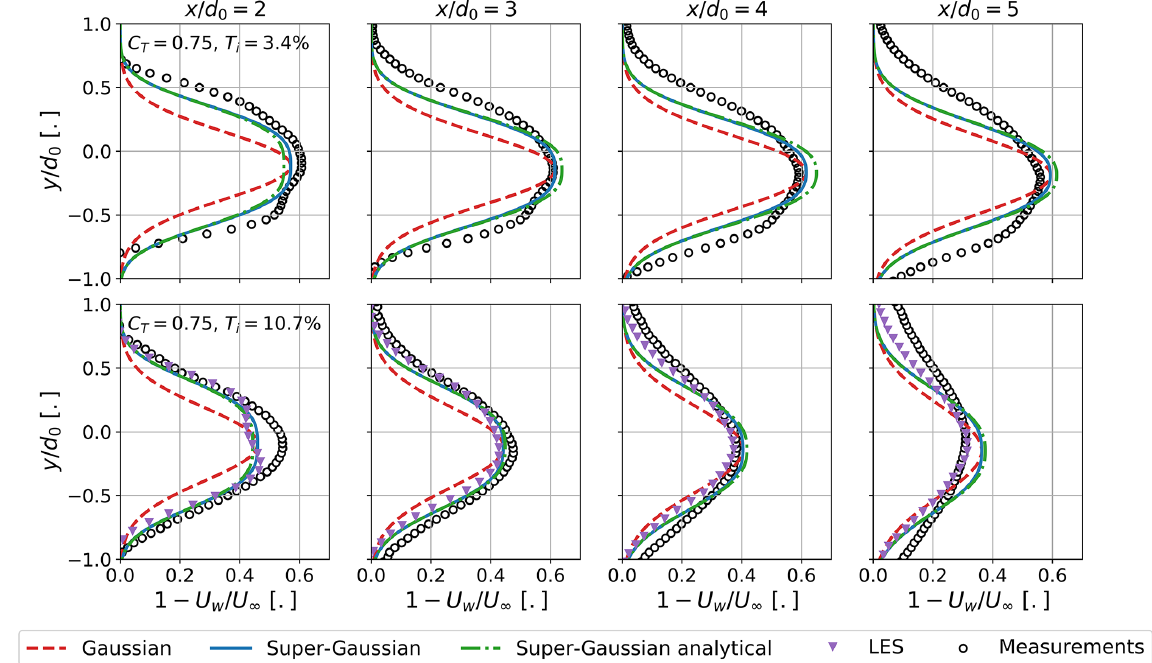
Figure 5. Normalized velocity deficit at four axial distances behind the wind turbine. Stable case (WT-S; top) and nearly neutral case (WT-N;